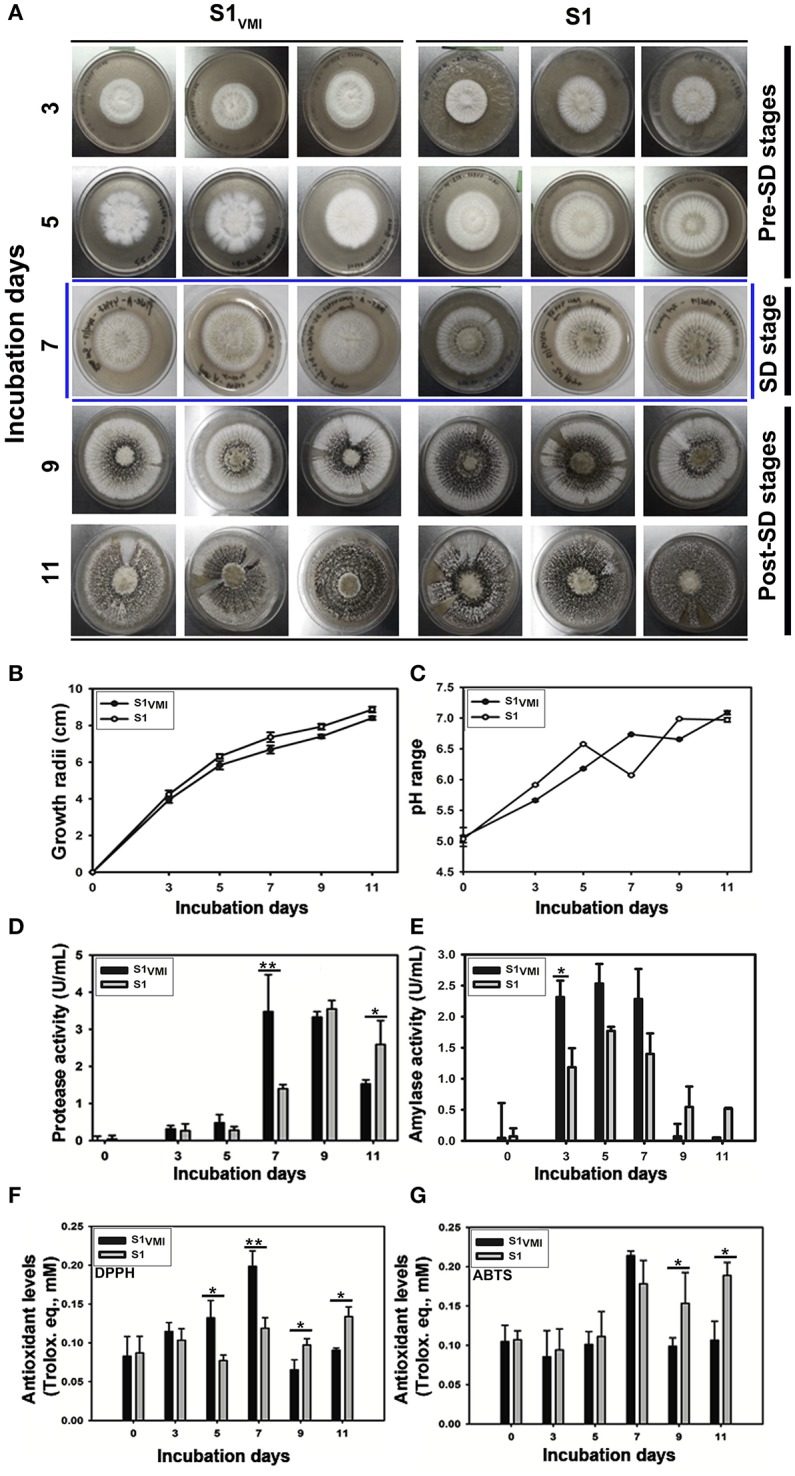
A time-correlated comparative evaluation of (A) culture morphology and SD, (B) growth profiles, (C) media pH variations, (D) protease activity, (E) Amylase activity, (F) DPPH antioxidant assay, (G) ABTS antioxidant assay, for the sclerotia forming A. oryzae RIB 40 (S1VMI and S1). Here, the data represent the mean ± SD of the triplicates representing three biological sets for each sample (S1VMI and S1). The asterisk representation for one-way ANOVA Dunkan-Tukey pair-wise comparison test indicates, **p < 0.01, *p < 0.05.